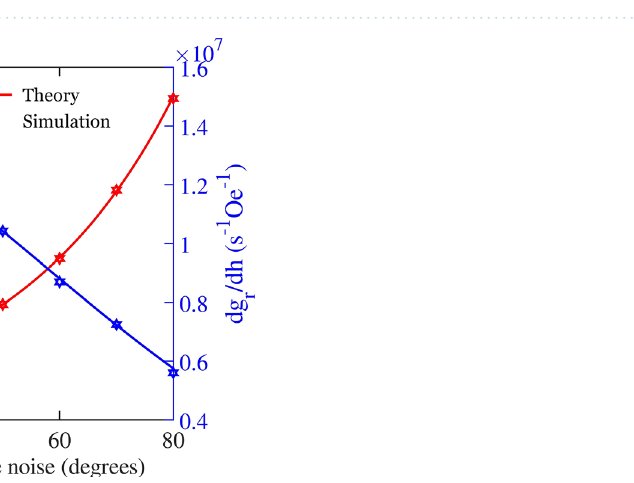
Figure 3. Growth rate of magnons vs. the primary r.f field intensity for various phase-noise standard deviations. ‘T’ refers to temporal noise, ‘S’ to spatial noise. The black solid lines with hollow symbols correspond to temporal noise while the red dotted lines with filled symbols correspond to spatial noise. The quantity in degrees indicates the standard deviation, σ , of the phase noise.